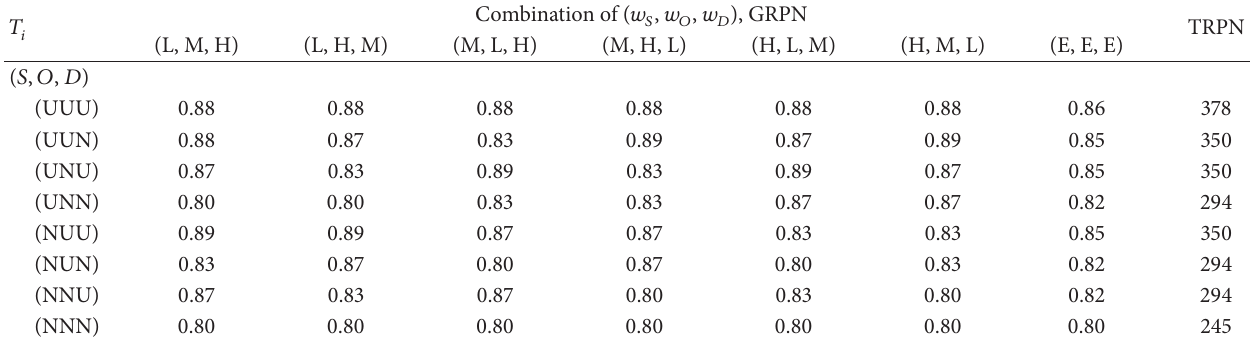
Table 8: Threshold value ( 𝑇 𝑖 ) for each of the combinations with 𝛼 = 0.9 .